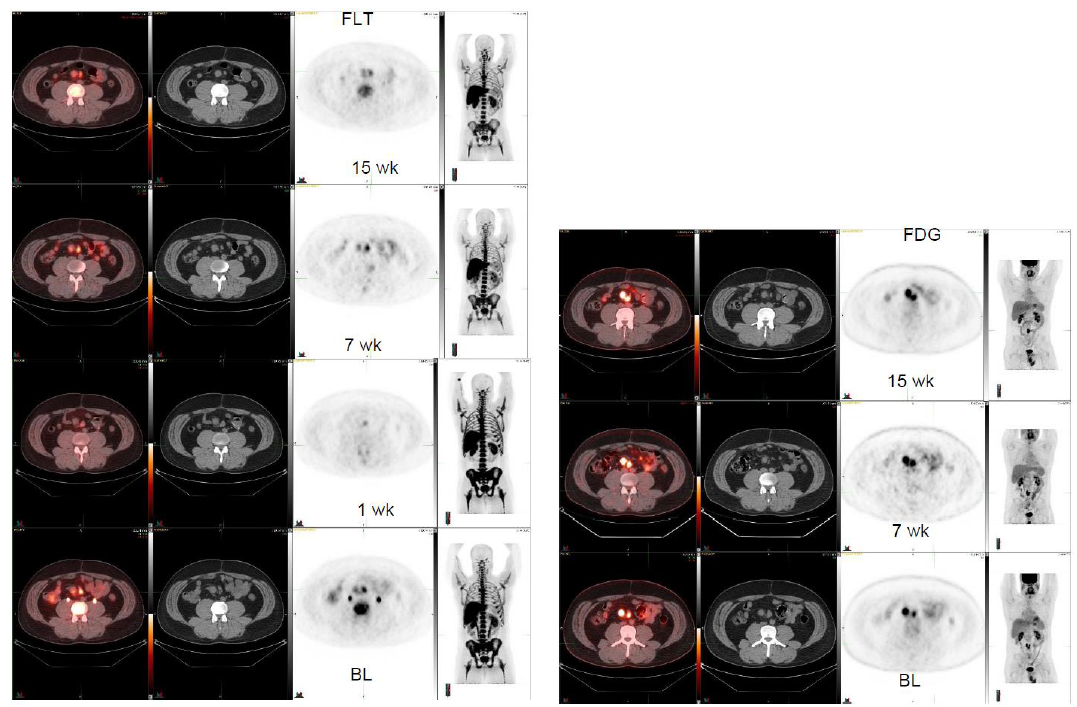
Figure 1. Gastro neuroectodermal tumor (GNET). FLT-study at baseline, at 1, at 7, and at 15 weeks (left panel, 4 rows). In the right mesenteric lymph node, FLT varies: SUVmax 5.2 ->3.2 -> 3.9->2.8 whereas corresponding sizes change on CT as follows: 2.2 cm × 1.9 cm ->2.0 cm × 1.8 cm->2.0 cm × 2.0 cm ->1.9 cm × 1.7 cm. In the left mesenteric lnn, FLT varies: SUVmax 5.5 ->3.4 -> 5.9->4.0 whereas corresponding sizes change on CT as follows: 2.3 cm × 1.6 cm ->1.9 cm × 1.5 cm->2.1 cm × 1.4cm ->2.0 cm × 1.2 cm. FDG-study at baseline, at 7, and at 15 weeks (right panel, 3 rows). In the right mesenteric lnn, FDG varies: SUVmax 12.9 ->nm -> 15.4->10.6 and in the left mesenteric lnn: SUVmax 8.2 ->nm -> 9.9->8.0.